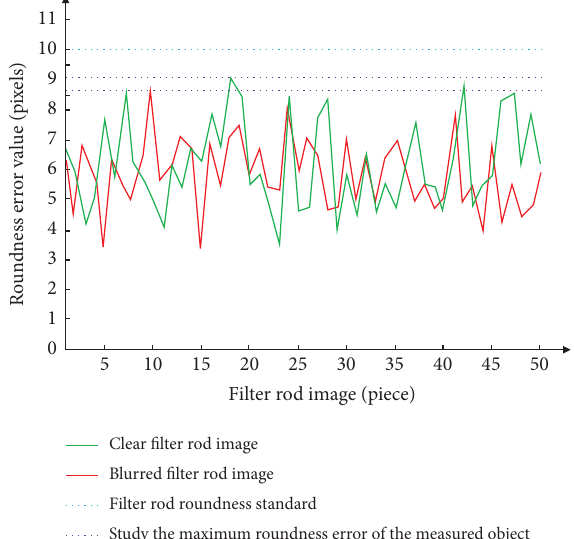
Figure 11: Actual flter rod roundness error test results.